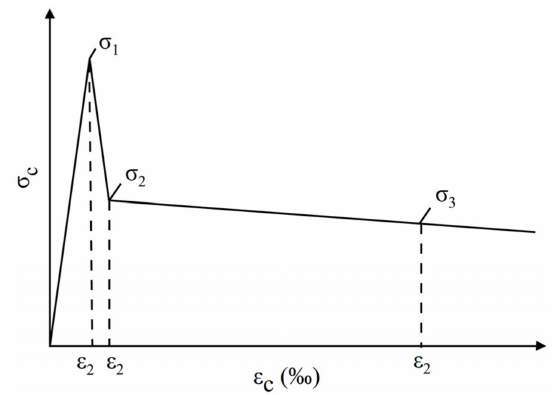
Figure 10. Tensile constitutive derivation curve